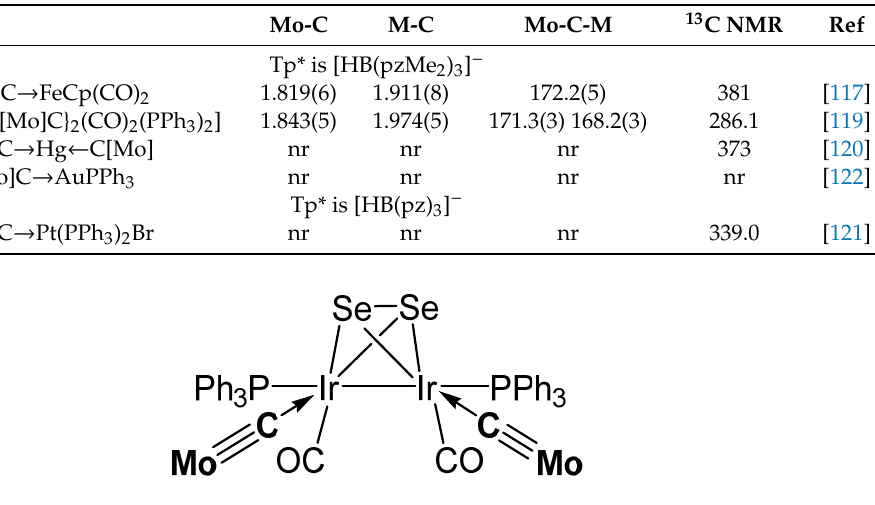
Figure 32. Tetrameric unit from [W]C → AuAsPh 3 and [W]C → AuPPh 3 [122]. The terpyridine complex salt {[W]C → Pt(terpy)}PF 6 was obtained from [W]C-Li and [PtCl(terpy)]PF 6 ; the neutral complex [W]C → PtCl(terpyC[W]) (see Figure 33) was prepared from the same starting material and [PtCl 2 (phen)] (see Table 17) [ Error! Reference source not found. ]. Figure 33. Structural representation of [W]C → Pt complexes [ Error! Reference source not found. ]. Table 17. Compounds with [W] - C core. Tp* = [HB(pzMe 2 ) 3 ] − . W-C